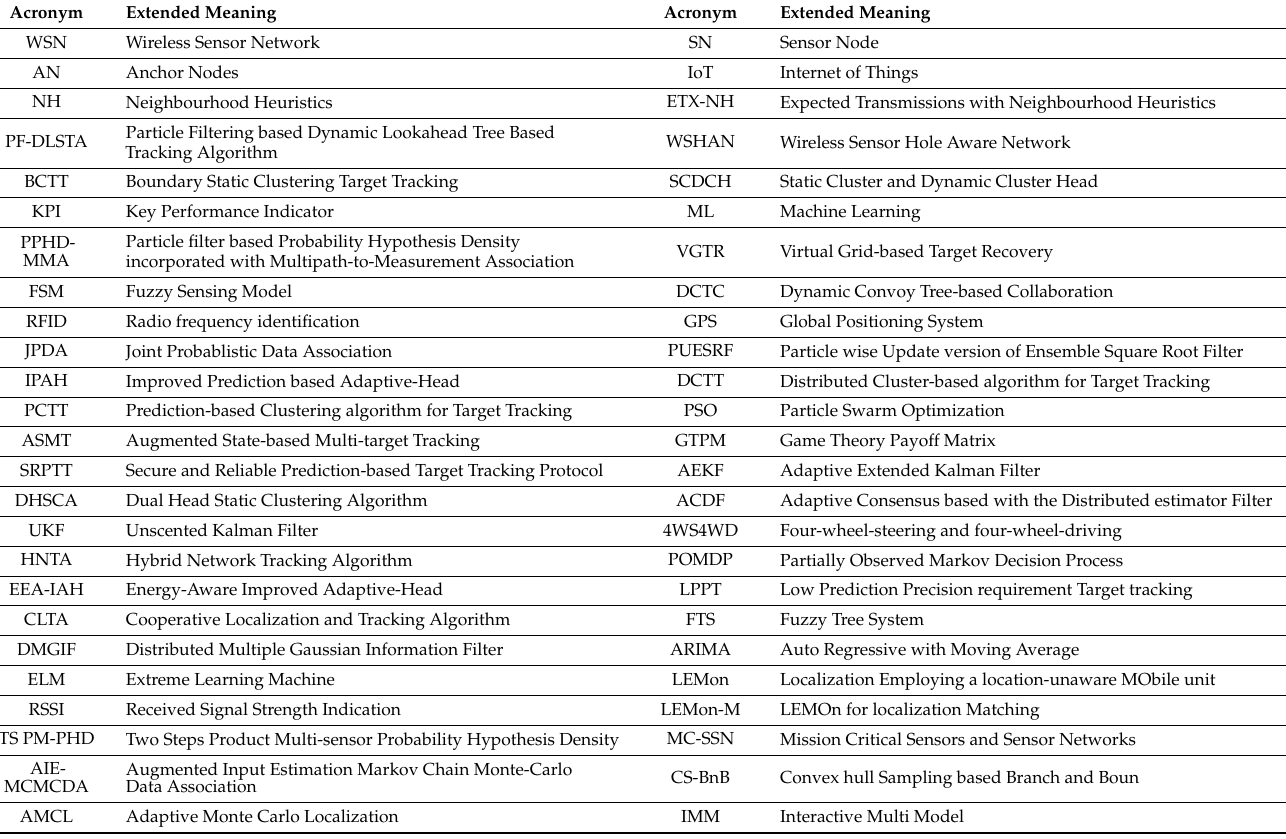
Table 1. List of important